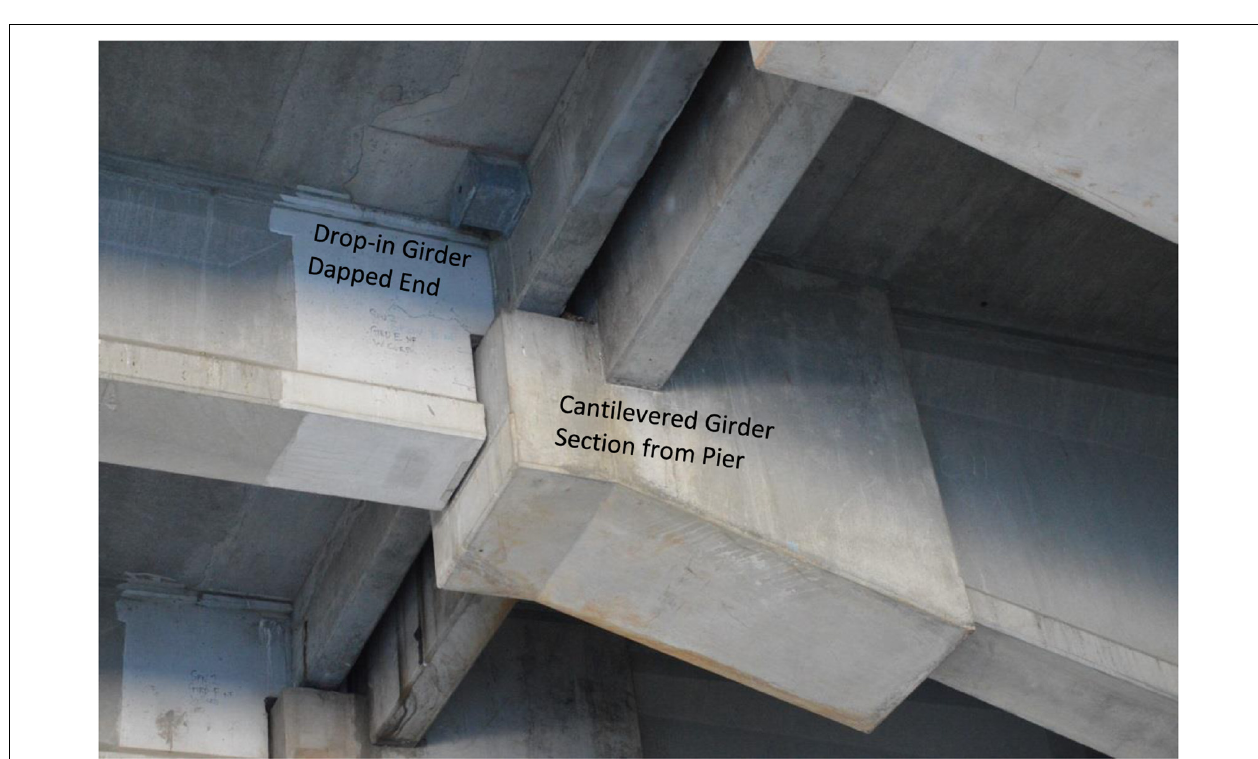
32 strain sensors in the plan view and cross section view. Of these strain sensors, 26 measure the effects of shear at the dapped end of all six (6) drop-in girders (four on each east end of all six girders and two on west end of Girder F), four (4) measure the effects of